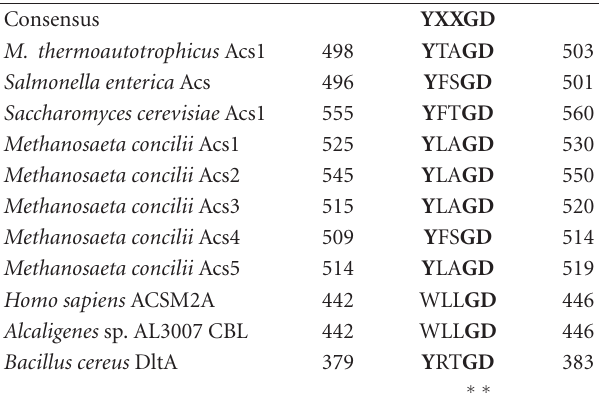
Table 1: Alignment of motif III residues in Acs sequences.